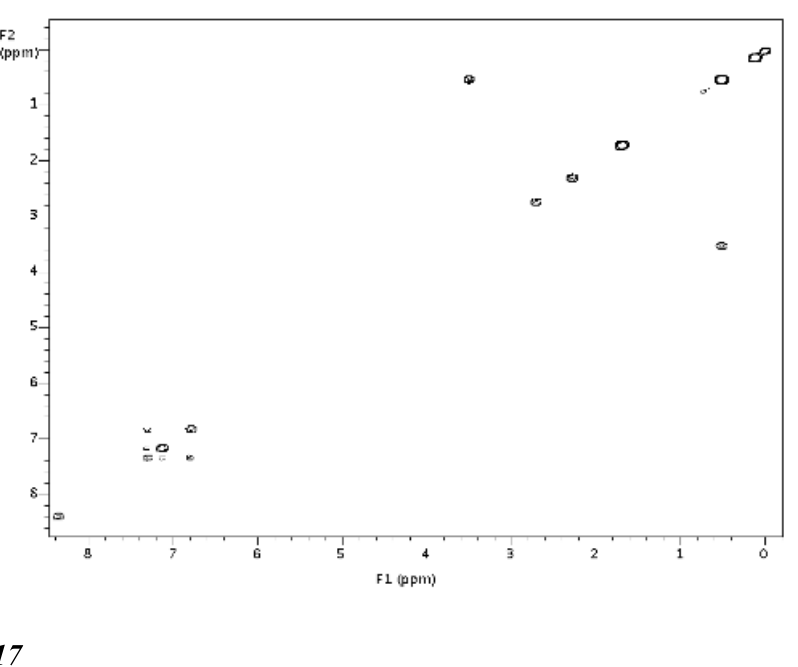
Figure 4. Graphical 1 H- 1 H COSY spectrum for 14